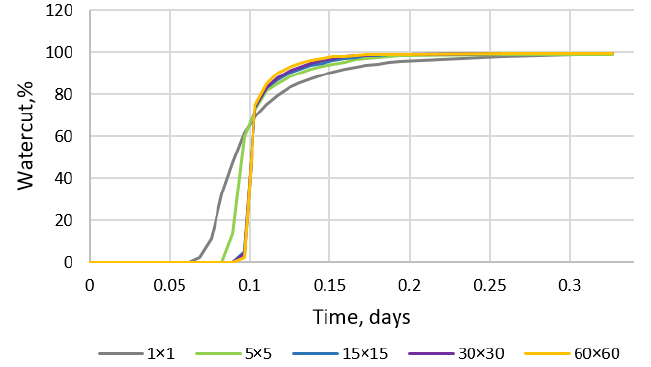
Figure 10. Oil recovery comparison.